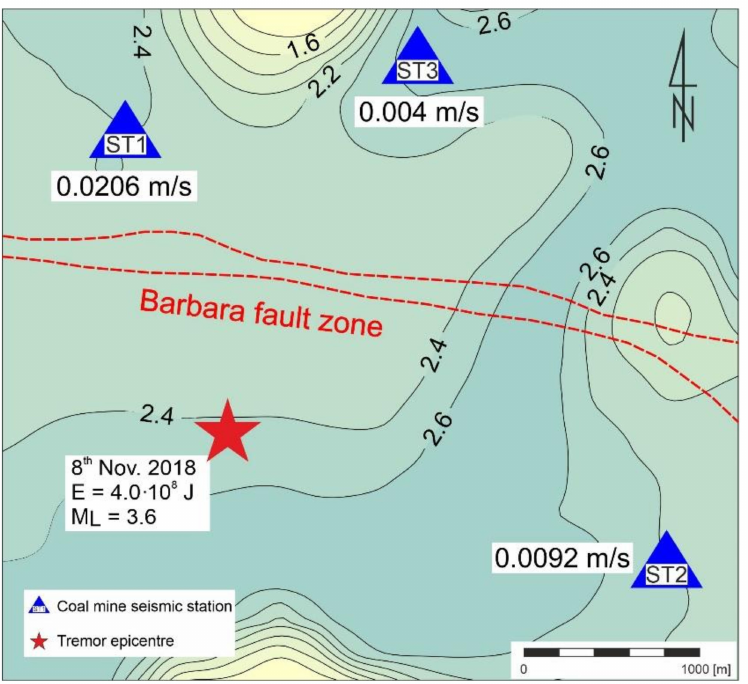
Figure 5. Map of the vibration amplification factor W f isolines of the tremor of 8 November 2018 with AMAX seismometric